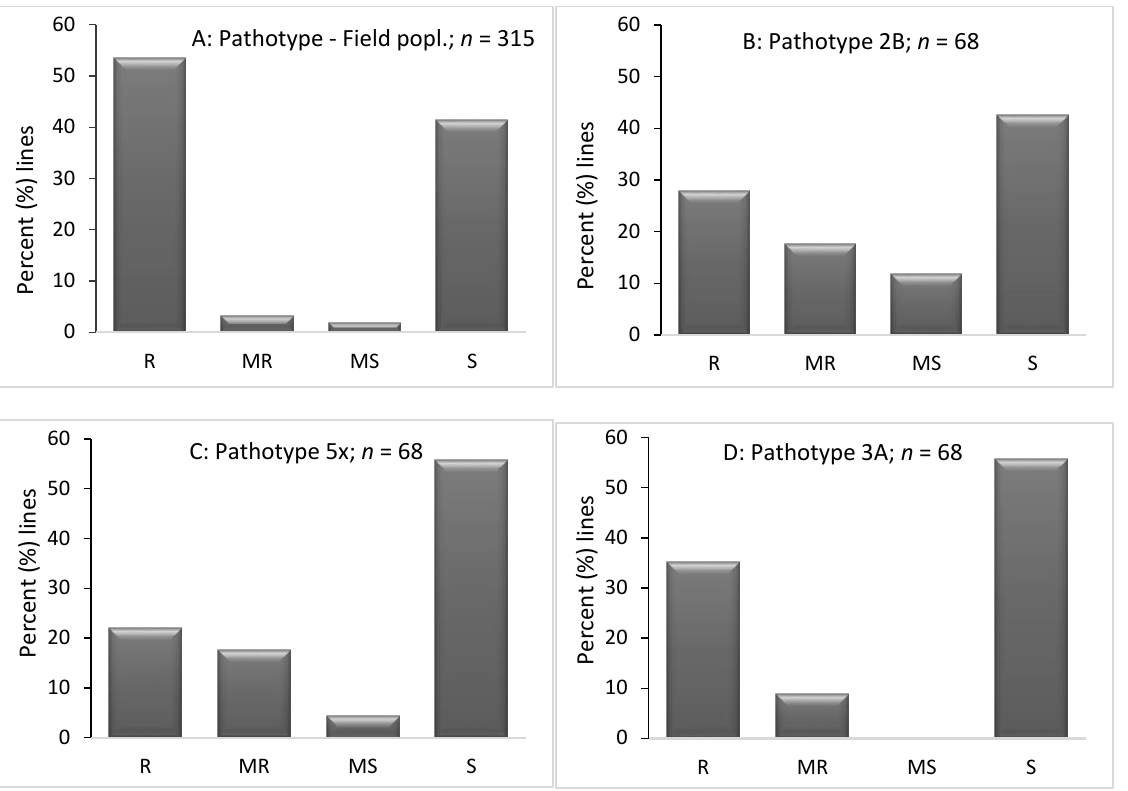
Figure 1. Distribution of the BC 1 F 8 generation Brassica napus lines derived from the ( B. napus × B. rapa ) × B. napus interspecific cross exhibiting clubroot resistance under field conditions and to dif- ferent Plasmodiophora brassicae pathotypes under greenhouse conditions: ( A ) Field condition in Al- berta, ( B ) pathotype 2B, ( C ) pathotype 5x (L-G1), ( D ) pathotype 3A, ( E ) multiple pathotypes ( x -axis: 3H-R/3A-R/5x-R/2B-R = resistant to all pathotypes (3H, 3A, 5x and 2B); 3H-R/3A-R/5x-R/2B-MR = resistant to pathotypes 3H, 3A and 5x while moderately resistant to pathotype 2B; 3H-R/3A-R/5x- MR/2B-R = resistant to pathotypes 3H, 3A and 2B while moderately resistant to pathotype 5x; 3H- R/3A-R/5x-MR/2B-MR = resistant to pathotypes 3H and 3A while moderately resistant to pathotypes 5x and 2B; 3H-R/3A-R/5x-MS/2B-R = resistant to pathotypes 3H, 3A and 2B while moderately sus- ceptible to pathotypes 2B; 3H-R/3A-MR/5x-R/2B-MR = moderately resistant to pathotypes 3A and 2B while resistant to pathotypes 3H and 2B; 3H-R/3A-MR/5x-MR/2B-R = moderately resistant to